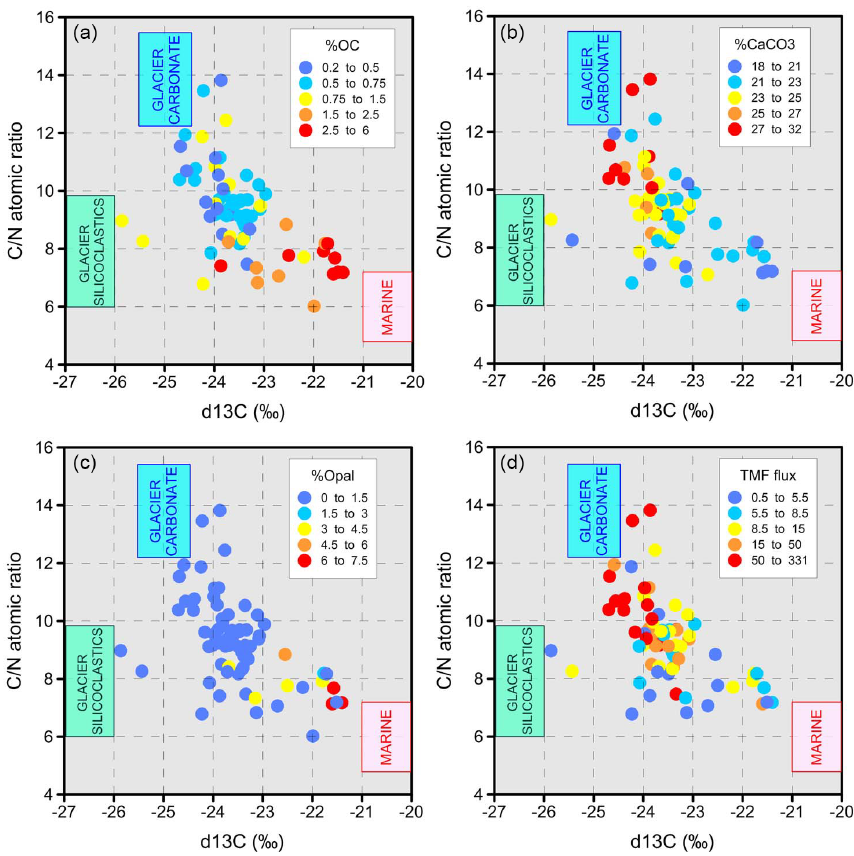
Figure 5. Relationship between δ 13 C and C / N for all samples plotted against %OC (a) , %CaCO 3 (b) , opal (c) , and TMF (d) . Coloured areas represent the estimated ranges of organic carbon